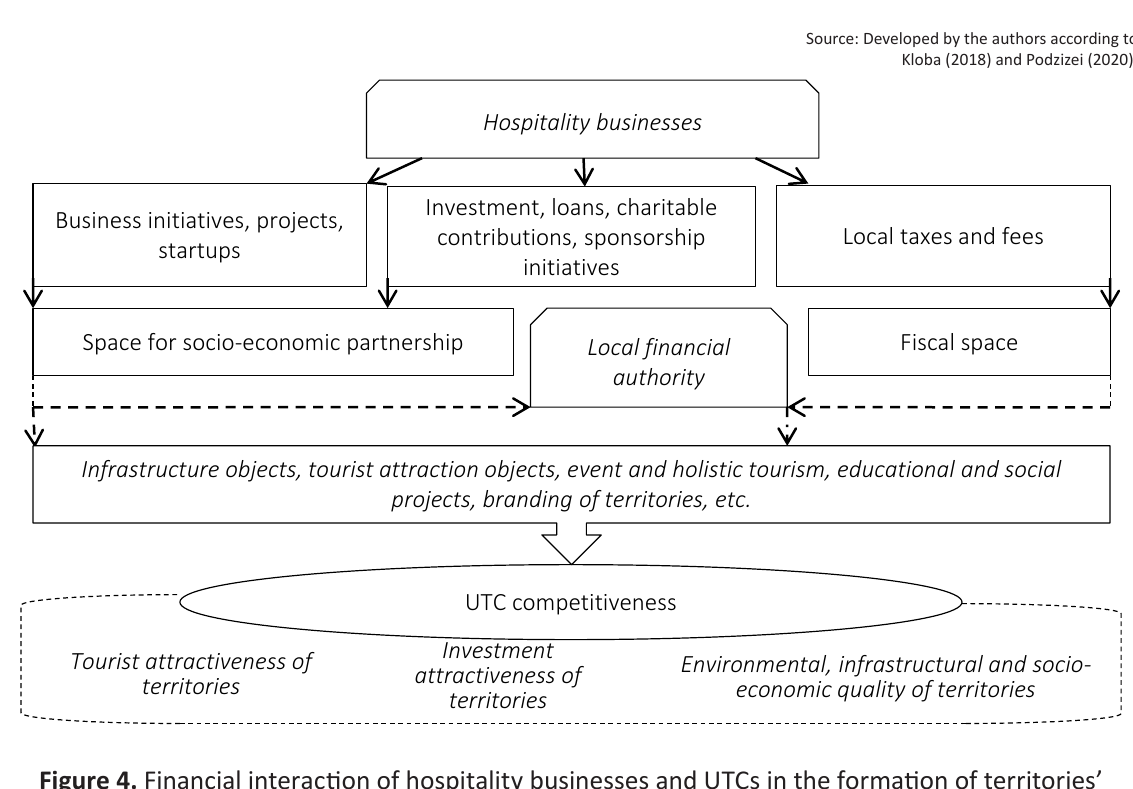
Figure 4. Financial interaction of hospitality businesses and UTCs in the formation of